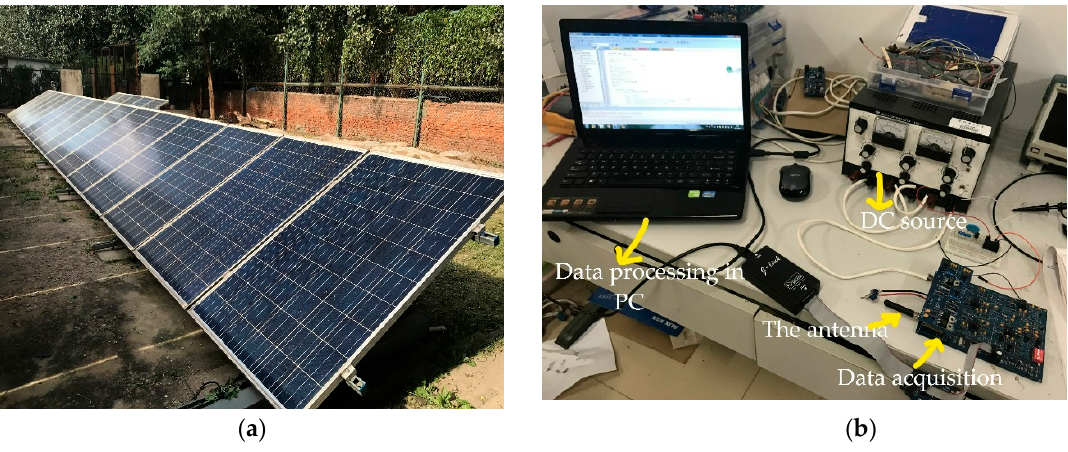
Figure 6. The experimental platform. ( a ) The experimental photovoltaic system; ( b ) The experimental instrument. DC: Direct Current.